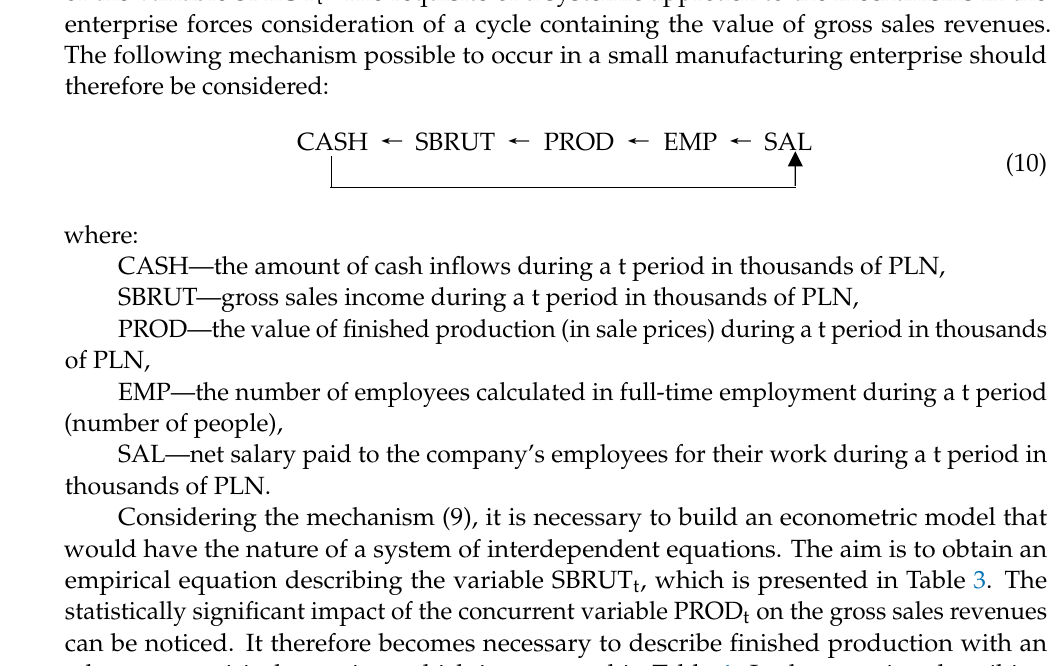
Table 2. Dependent variable: EVIND t ; observations used 1997:03–2003:12 (N = 82).